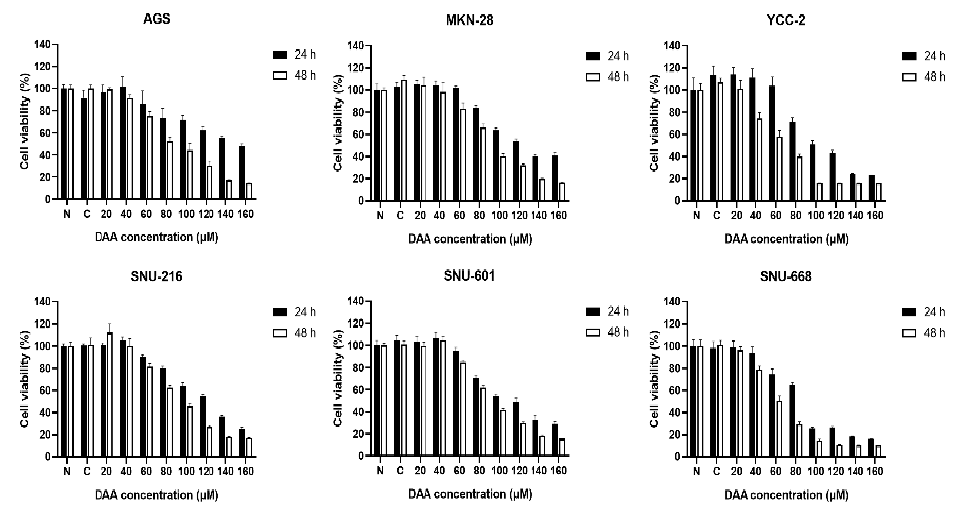
Figure 1. DAA inhibited the cell growth in gastric cancer cells. WST-8 assays were performed to detect the cell viability by DAA treatment for 24 and 48 h in six gastric cancer cell lines (AGS, MKN-28, YCC-2, SNU-216, SNU-601, and SNU-668). Data are presented as mean ± SEM ( n = 5). The statistical analysis was carried out by two-way ANOVA, p <